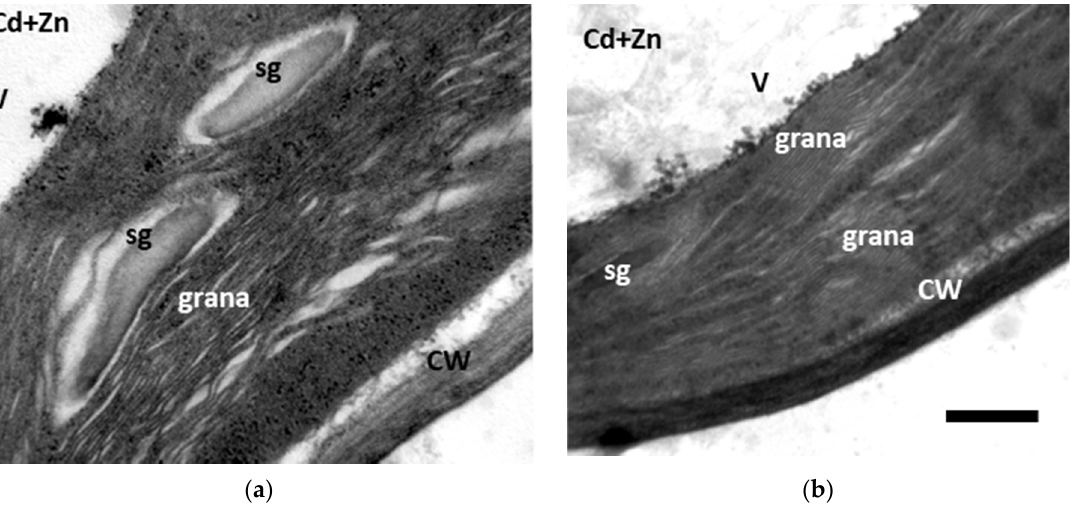
Figure 7. Transmission electron microscopy (TEM) images of chloroplasts from 8-day Cd 2+ +Zn 2+ - treated (nutrient solution + 100 μΜ Cd 2+ + 900 μΜ Zn 2+ ) Salvia sclarea leaves. Zn addition to the nu- trient solution mitigated Cd effects, with starch grains being present ( a ), and the thylakoid mem- branes being less dilated ( b ). CW : cell wall; sg : starch grain; V : vacuole. Scale bar: 200 nm.